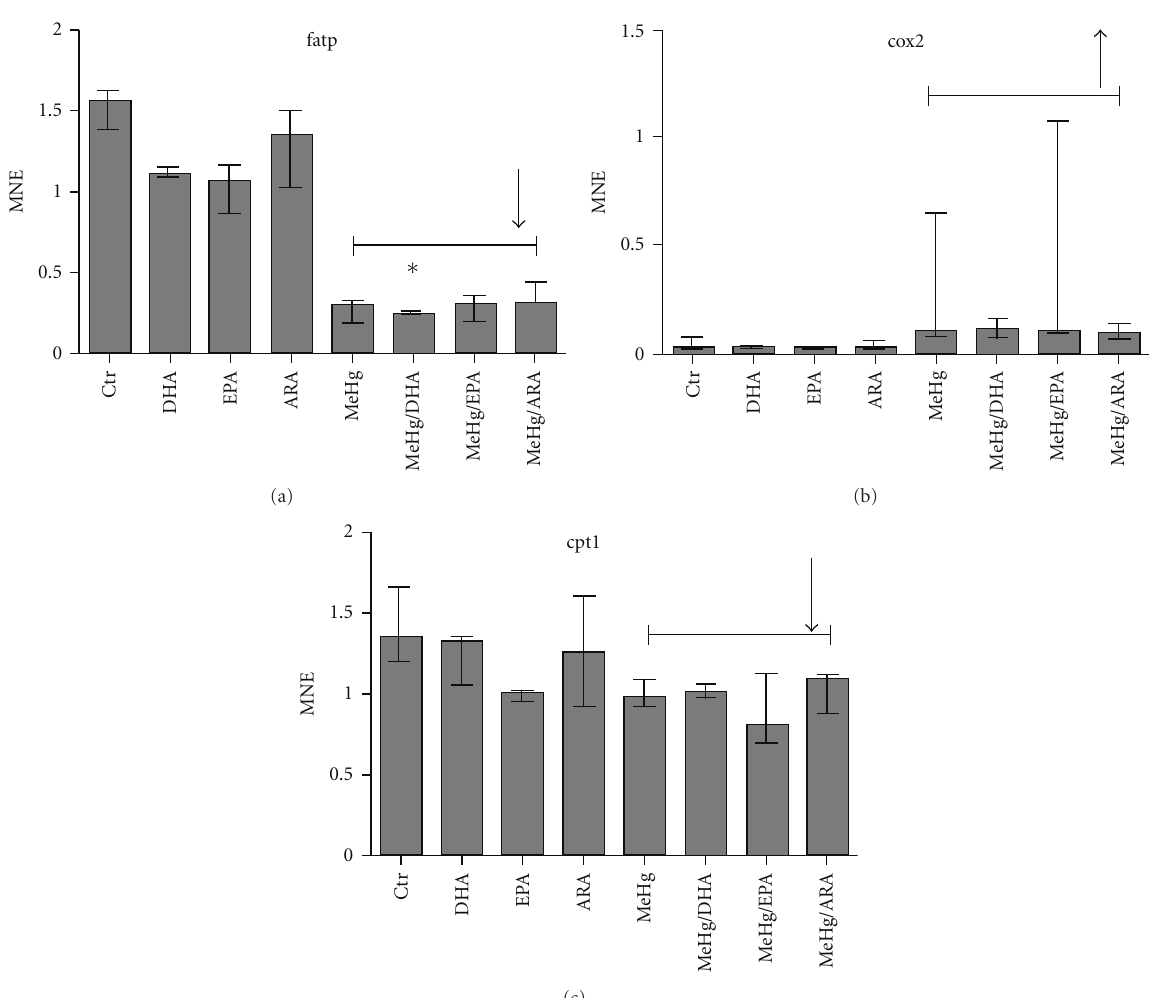
Figure 6: Mean-normalized expression (MNE) of (a) fatp, (b) cox2, and (c) cpt1 in ASK cells. Data are represented by median, with error bars representing interquartile range. Data are treated through factorial design, where n = 3 for all groups (columns shown), and significant di ff erences ( P ≤ 0 . 05) are indicated by asterix. MeHg and FA e ff ects were calculated across groups where n = 12 and n = 6, respectively. Significant e ff ects ( P ≤ 0 . 05) of MeHg are shown using bracket lines. Fatty acid e ff ects compared to control are shown by the letters FA. Statistical analysis was performed using nonparametric Kruskal Willis with post hoc paired